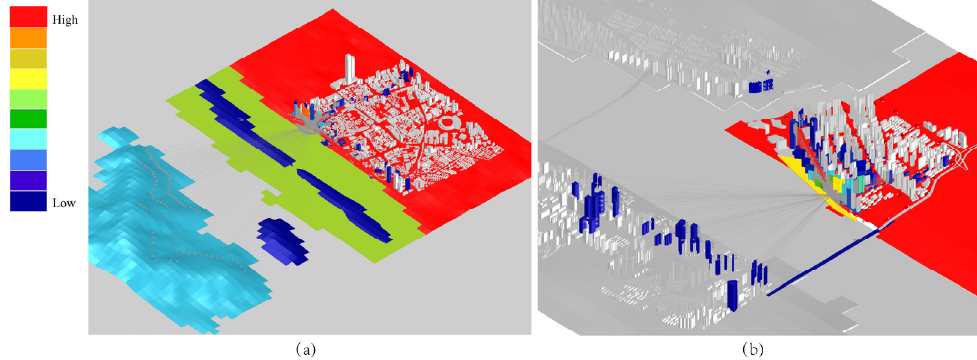
Figure 13. Measuring the visibility of landmarks using 3D isovists. ( a ) TP-District; ( b ) XD-District.